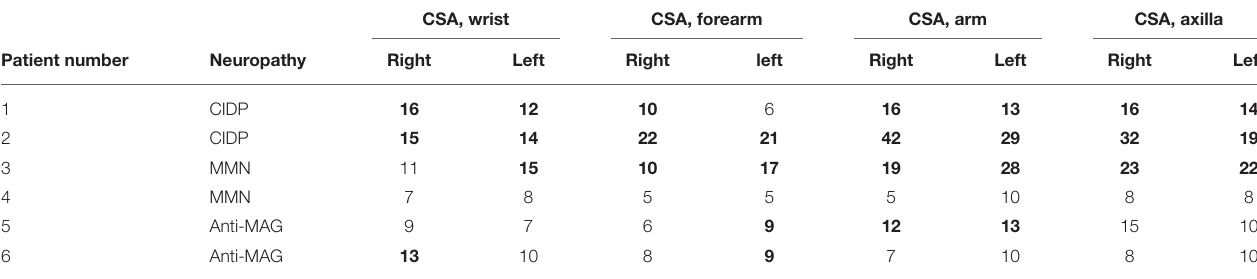
CSA measured in mm 2 . Abnormal values shown in bold.